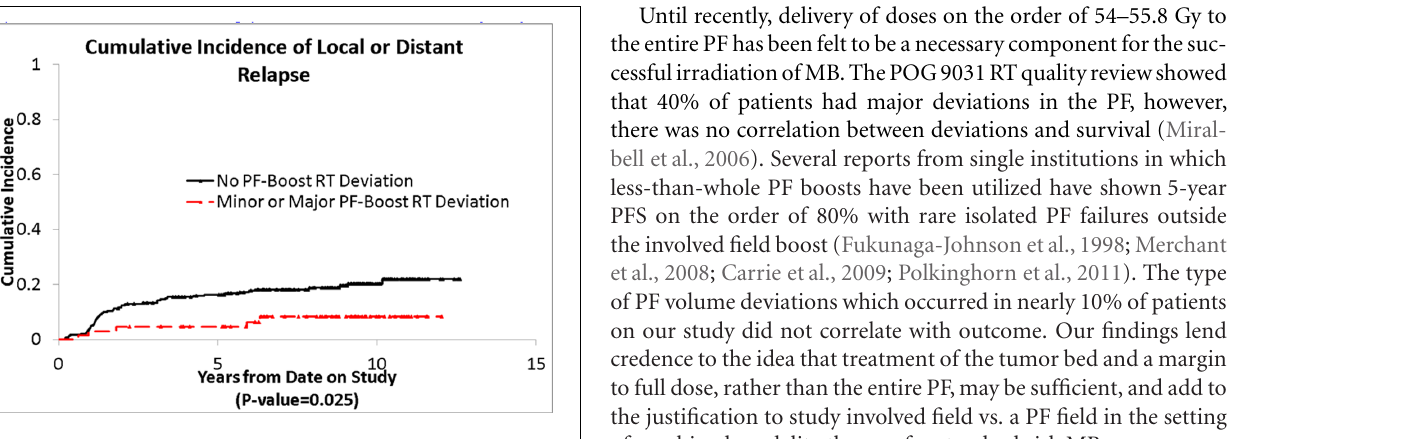
FIGURE 6 | Cumulative incidence of local and distant relapse by posterior fossa deviations.